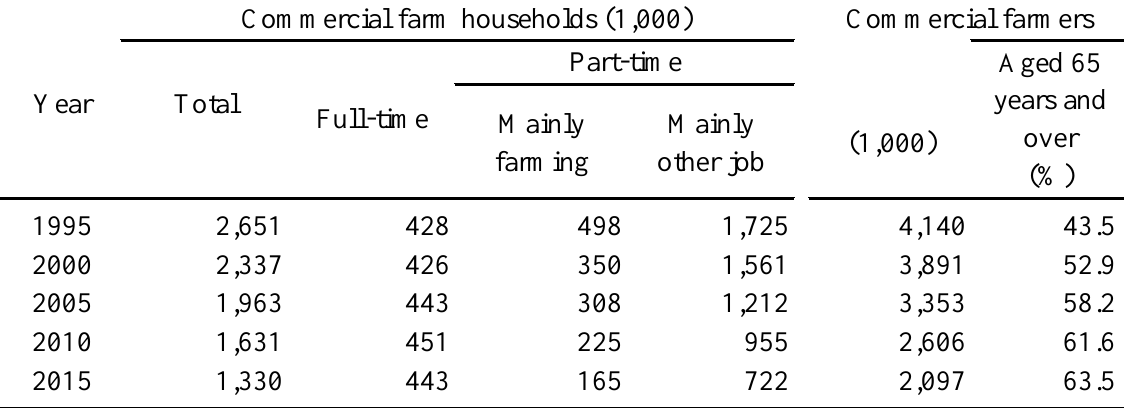
Commercial Farm Households and Commercial